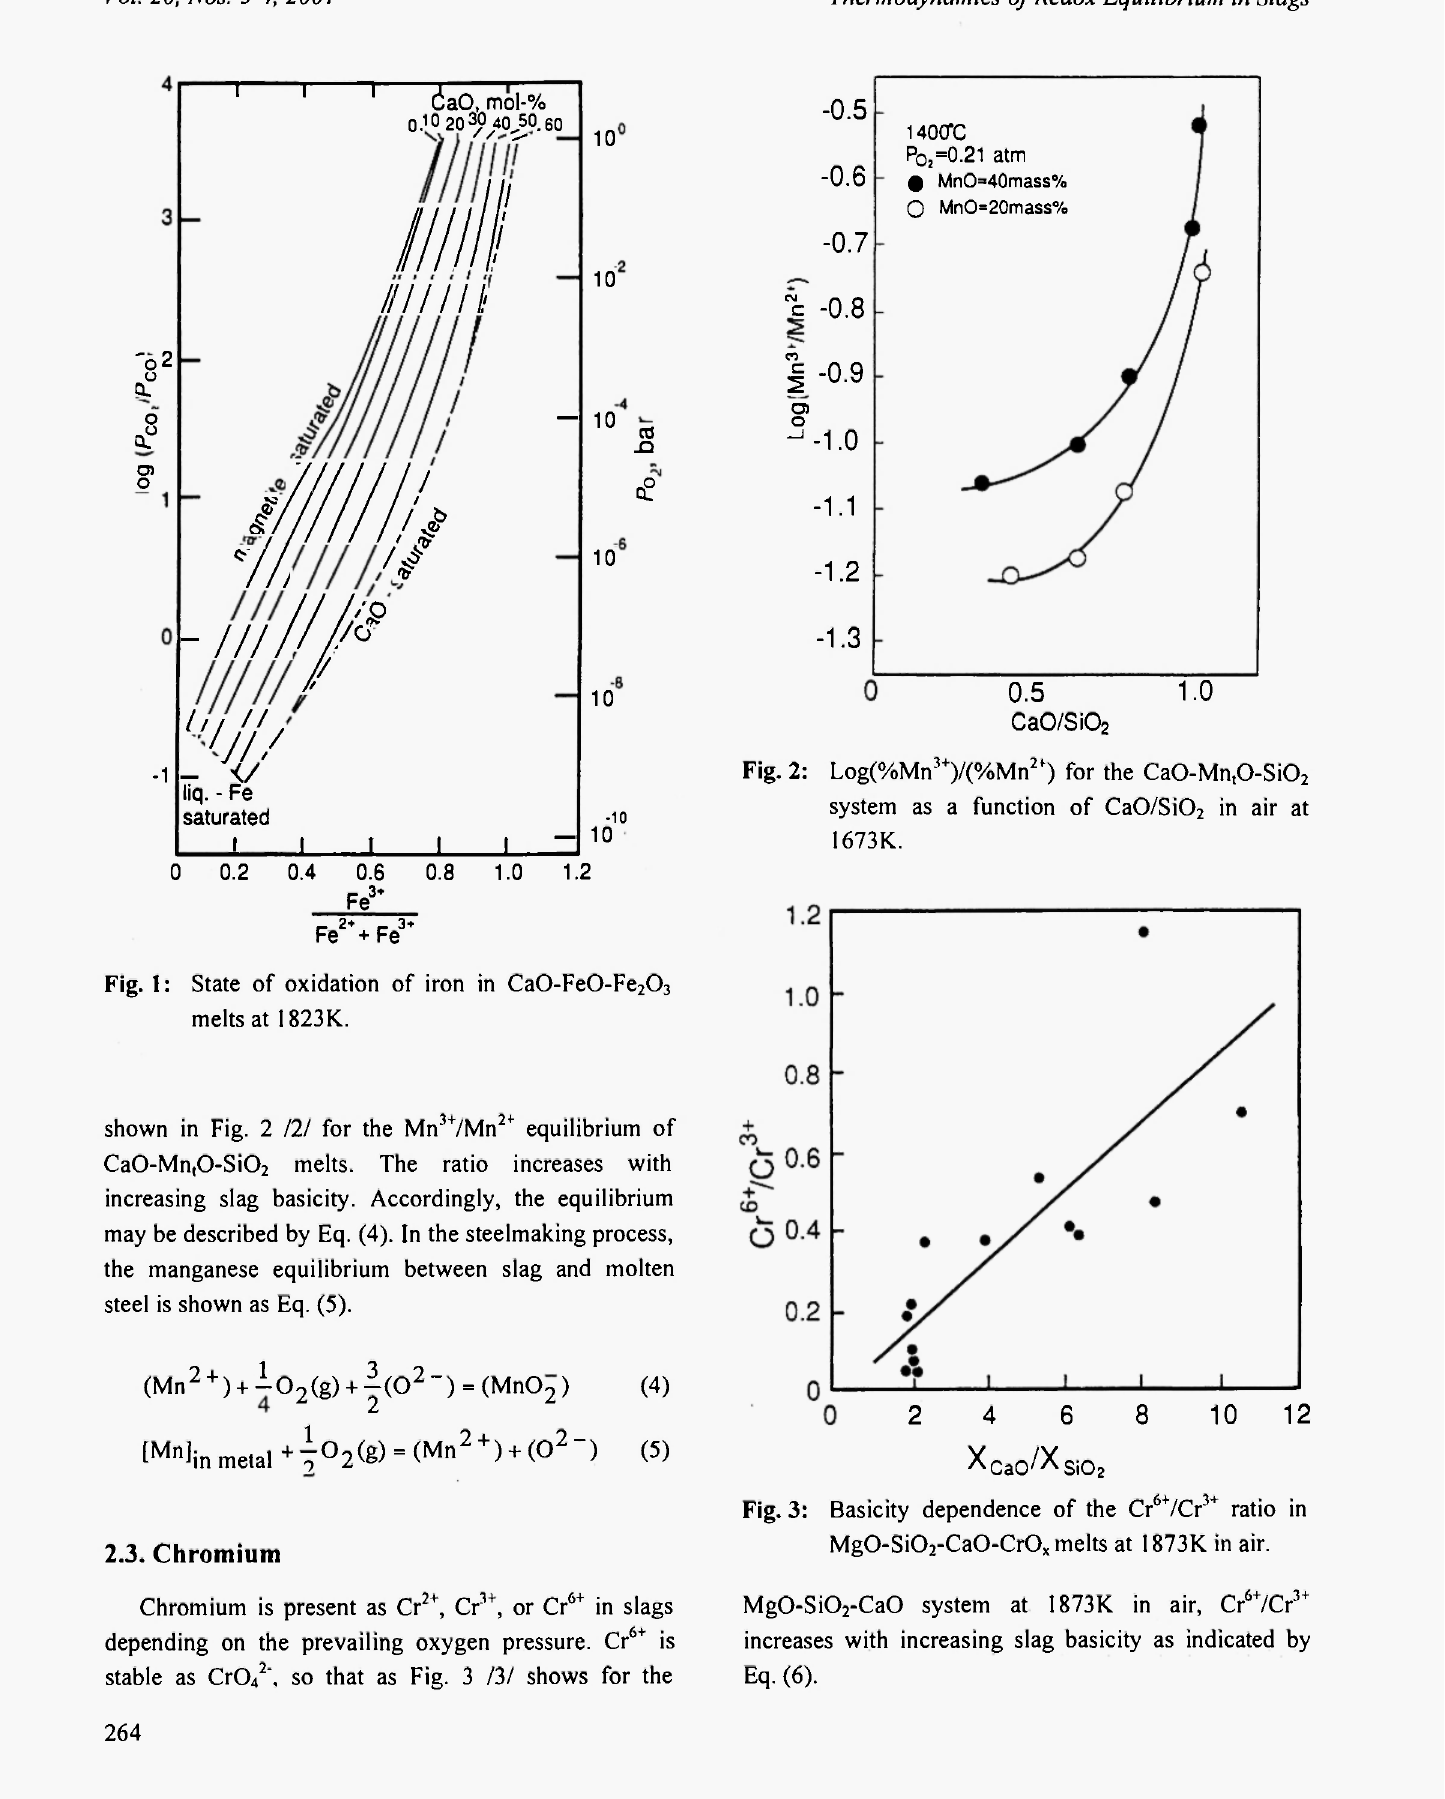
Fig. 3: Basicity dependence of the Cr 6+ /Cr 3+ ratio in Mg0-Si0 2 -Ca0-Cr0 x melts at 1873K in air. Mg0-Si0 2 -Ca0 system at 1873K in air, Cr 6+ /Cr 3+ increases with increasing slag basicity as indicated by Eq.